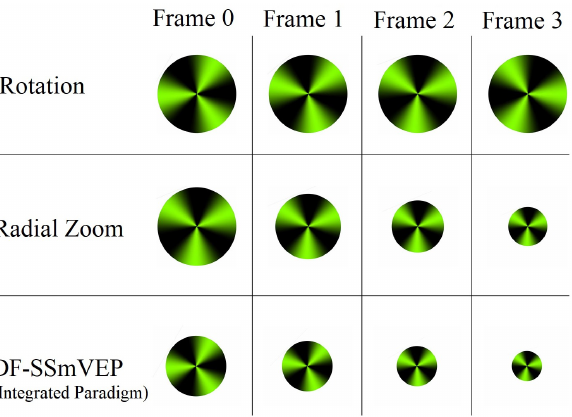
Figure 1. Proposed DF-SSmVEP paradigm developed by concurrent inclusion of two types of the motion (rotation and resizing).